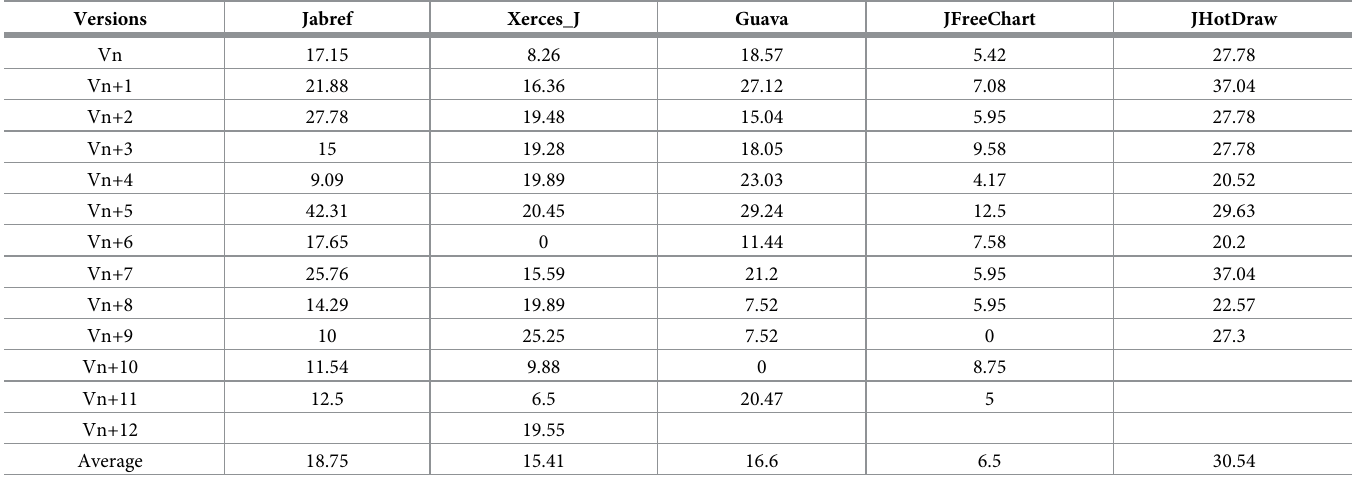
Table 5. Consistent refactored clones in versions of five Java